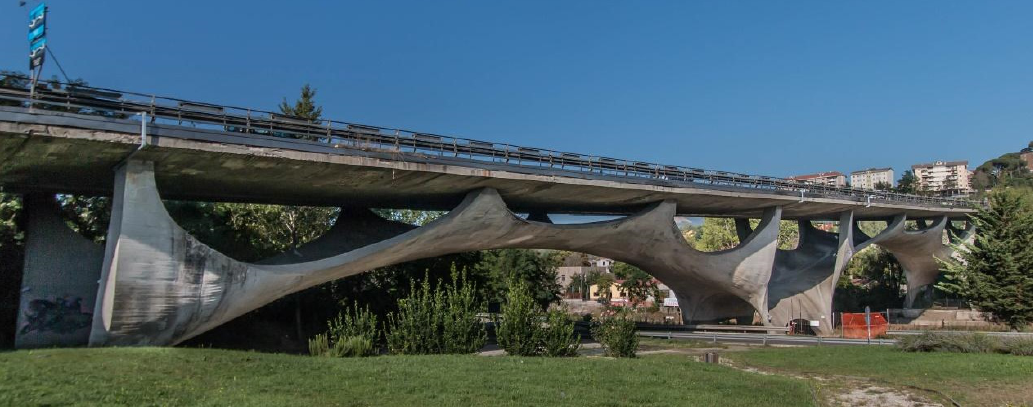
Figure 3. The Musmeci bridge at present.